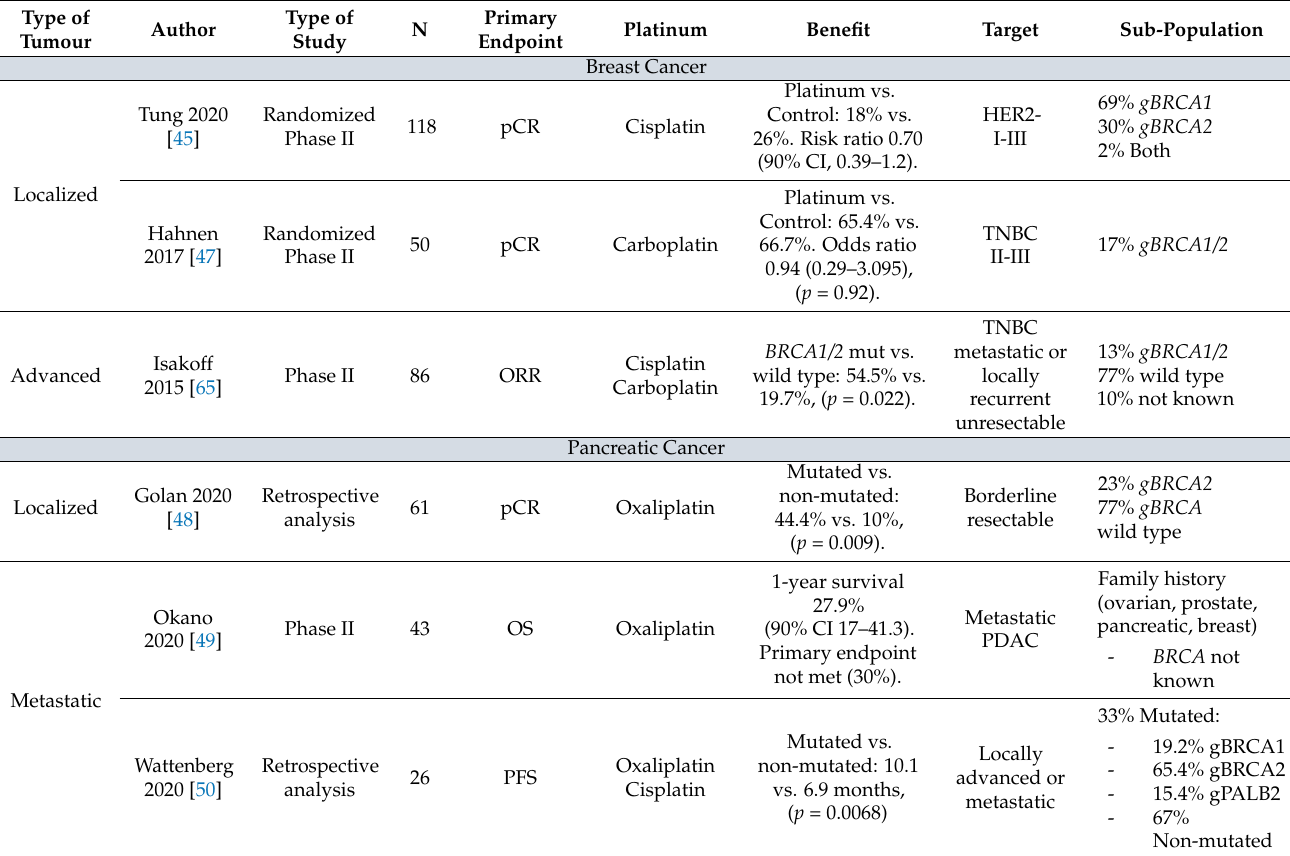
Table 1. Clinical trials evaluating platinum therapy for HRD tumor